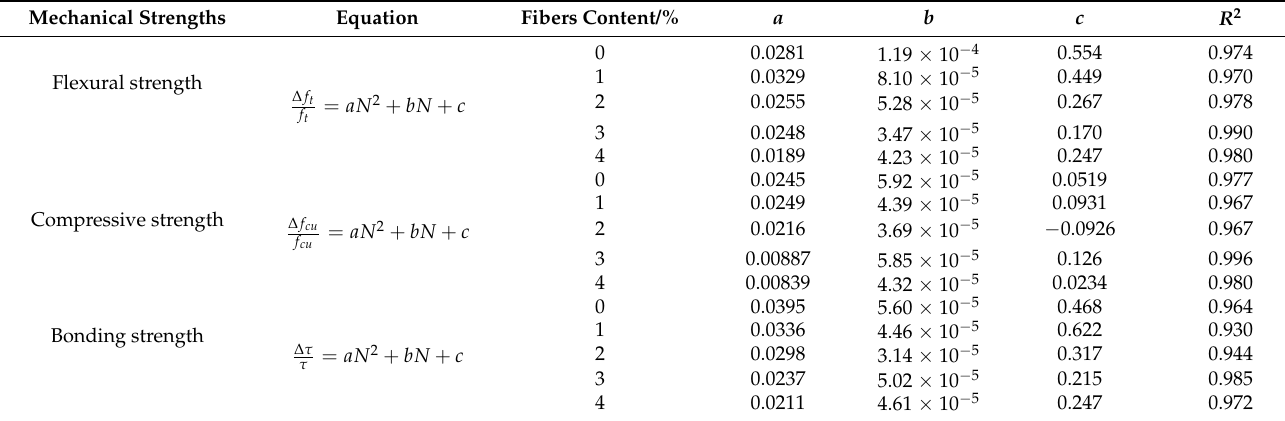
Table 4. The fitting results of mechanical loss rate and the number of NaCl freeze-thaw cycles ( N ).